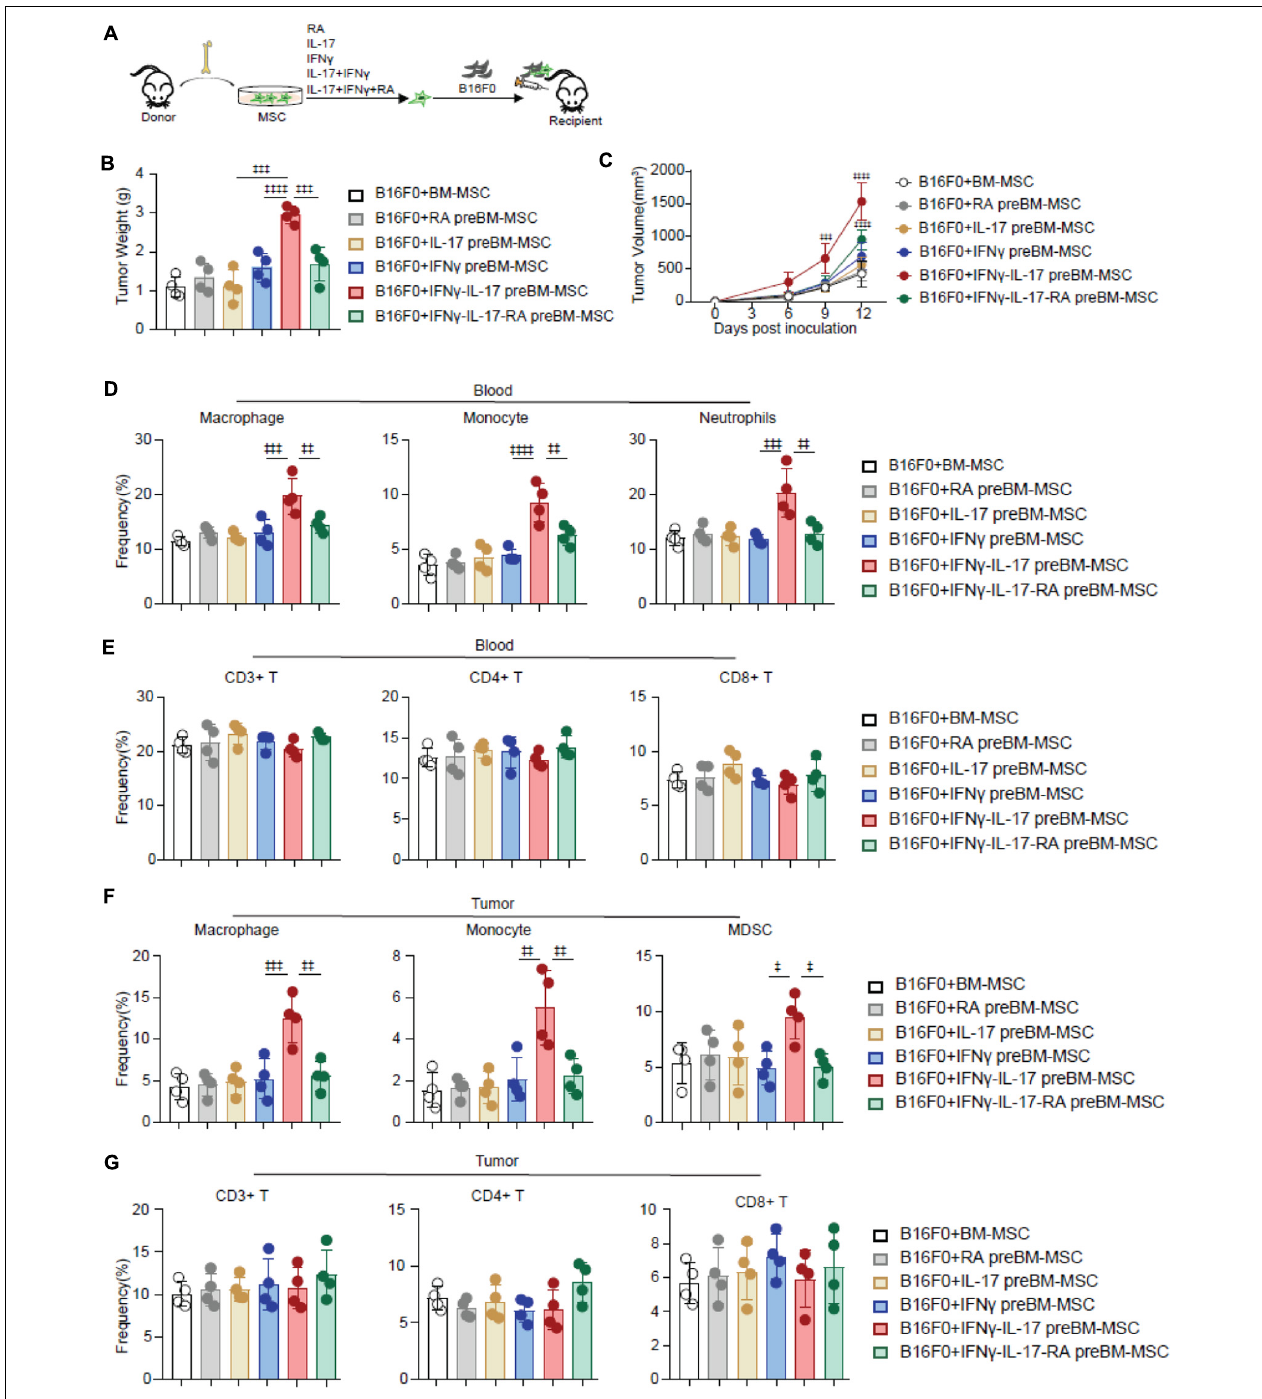
FIGURE 3 | RA inhibits TA-MSC transformation and suppresses TA-MSC mediated melanoma progress in vivo . (A) Schematic depicting the strategy to investigate the inhibition role of RA on IL-17 and IFN γ mediated TA-MSC transformation. (B,C) Tumor weight (B) and tumor growth curve (C) of mice inoculated with B16F0 cells, and B16F0 cells with BMSCs with indicated treatment ( n = 4–5). (D,E) The percentage of circulated macrophages, monocytes, neutrophils (D) , and T cells (E) in the peripheral blood. (F,G) The frequency of macrophages, monocytes, MDSCs (F) and T cells (G) in the tumor microenvironment of mice inoculated with B16F0 cells, and B16F0 cells with BMSCs with indicated treatment at 12 days after tumor cell inoculation ( n = 4). Data represent mean ± SD of 3 independent experiments. ‡ p < 0.05, ‡‡ p < 0.01, ‡‡‡ p < 0.001, ‡‡‡‡ p < 0.0001. ns, not significant.